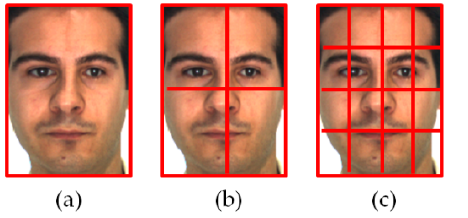
Figure 4. Examples of multi-block (MB) image decomposition: ( a ) 1 × 1, ( b ) 2 × 2, and ( c ) 4 × 4.